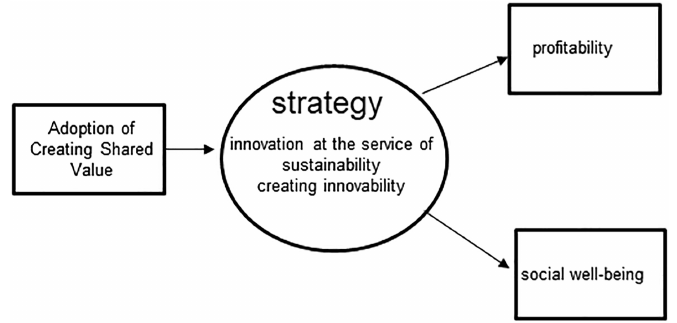
Figure 1. Theoretical